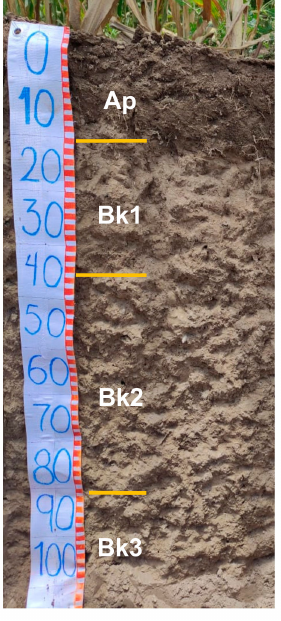
Figure 7. Profile of organic agricultural soil. Table 3. Agricultural soil profile